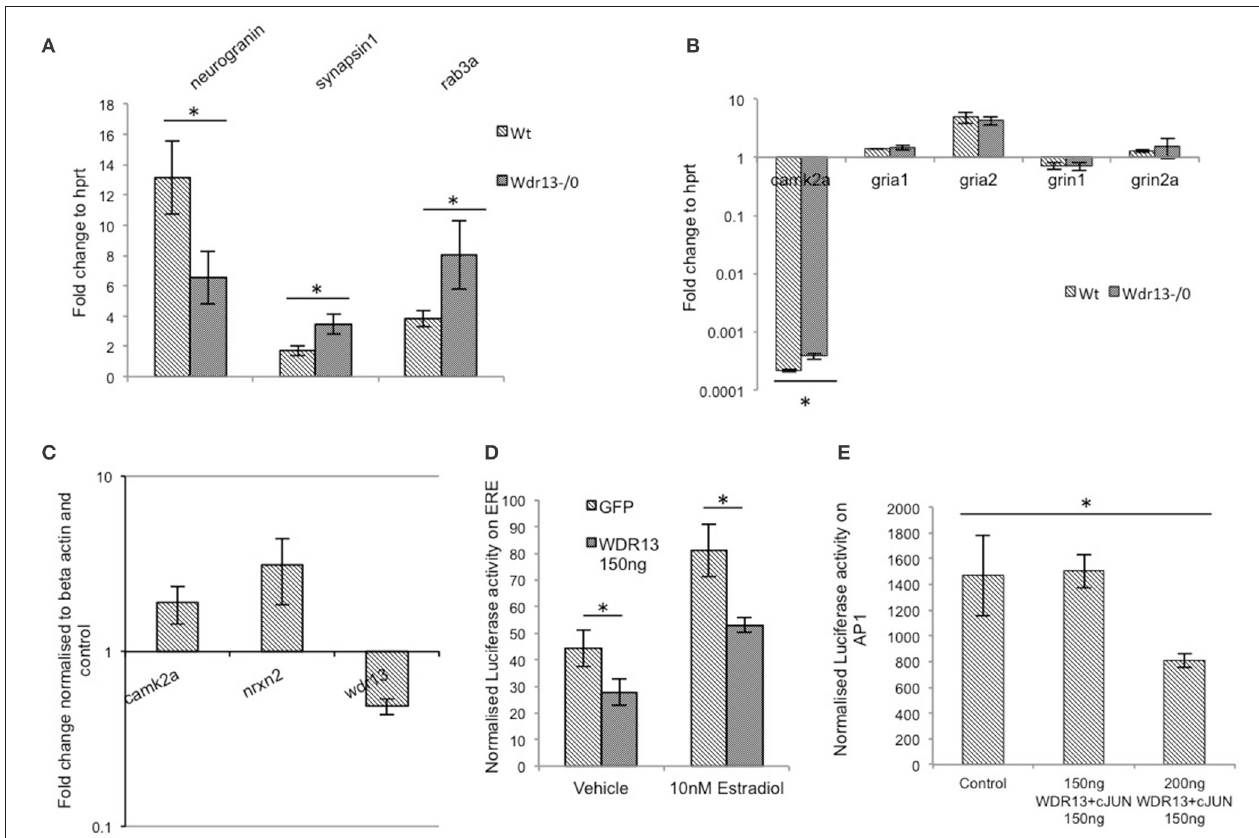
FIGURE 7 | (A) In Wdr13 − / 0 mice hippocampus, transcript levels of Syn1 (synapsin1) and Rab3a showed increase ( T -test; p < 0.05) and Nrgn (neurogranin) showed decrease ( p < 0.05) than the wild-type under non-stress conditions ( n = 5) Data represented as ± SEM. (B) In Wdr13 − / 0 mice, there were no significant changes in levels of Grin1, Grin2a, Gria1, and Gria2 in the hippocampus whereas transcripts of Camk2a were upregulated ( n = 4). Data represented as ± SD. (C) Knockdown of Wdr13 in Neuro2a cells using siRNA resulted in increased transcripts of Camk2a and Nrxn2 . Data represented as ± SD. (D) WDR13 repressed luciferase transcription from a promoter containing an ERE element in the presence of Estradiol (Mann Whitney; p < 0.05). (E) Luciferase activity of AP1 promoter containing vector in Neuro2a cells showed decrease upon co-expression of c-JUN with WDR13 (One way ANOVA; p < 0.05). Data represented as ± SD. Wt, wild-type; Wdr13 − / 0 , Wdr13 knockout mice. * p <